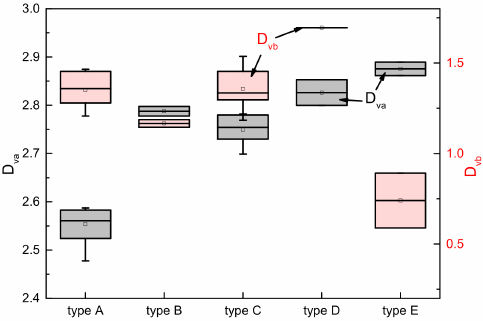
Figure 3. D va and D vb distribution of Type A–E.